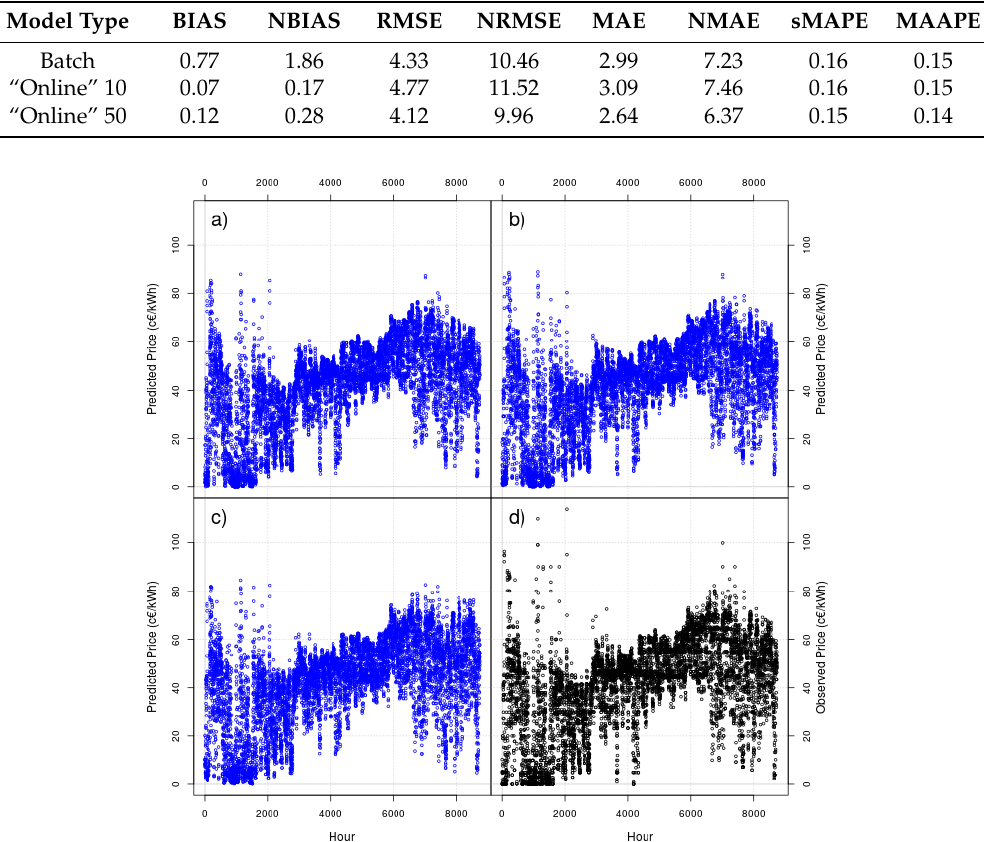
Figure 7. As blue points, one-hour ahead forecasts of RF. ( a ) “Online” RF for a moving window of 10 days, ( b ) “Online” RF for a moving window of 50 days and ( c ) Batch RF. As black points, ( d ) the 2014 real data to forecast.